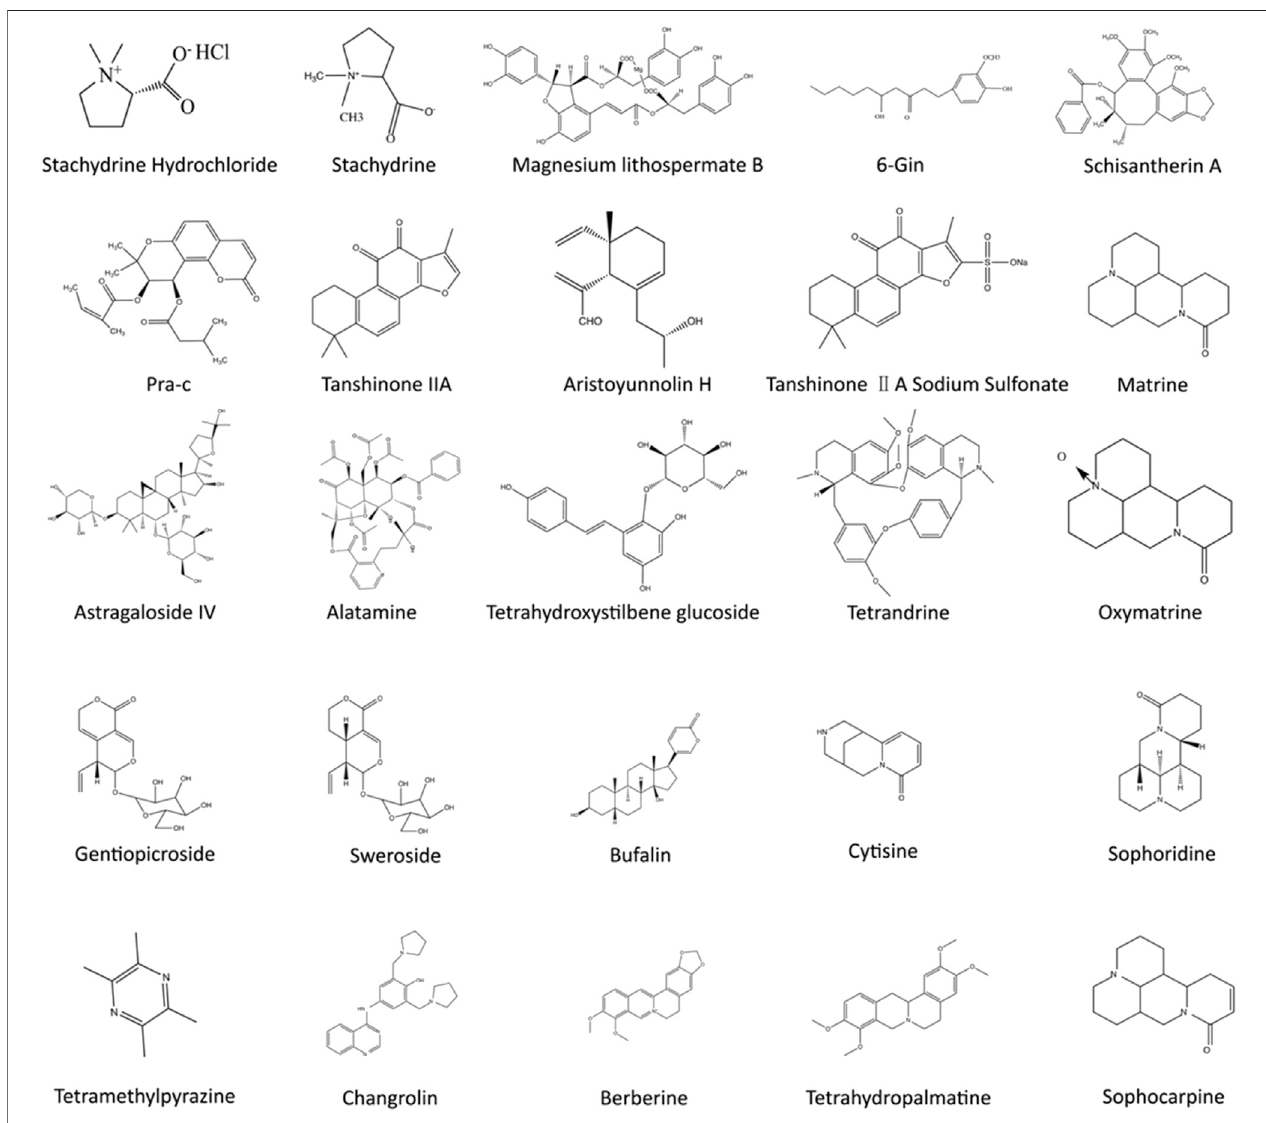
FIGURE 3 | Chemical structures of TCM bioactive components that regulate calcium signaling pathways.